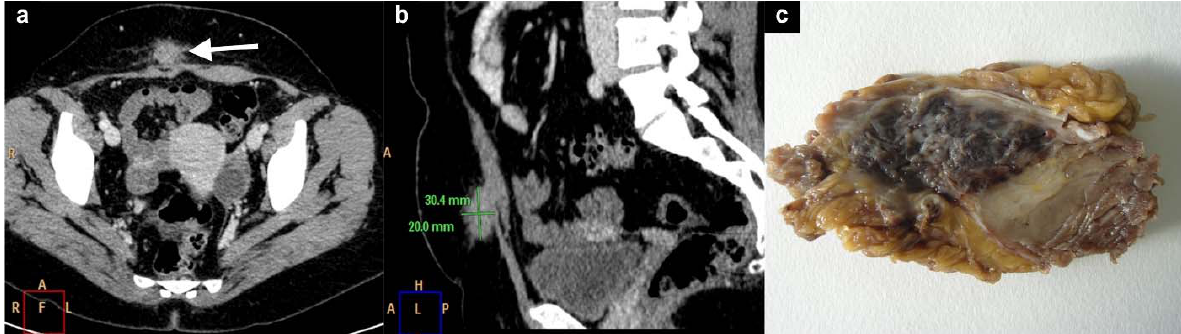
Figure 2. Axial ( a ) and Sagittal ( b ) CT images of a histologically proved ( c ) of subcutaneous endometriosis. A 30 × 20 mm 2 endometriotic nodule (white arrow in a) was detected superficially and in contiguity with the right rectal muscle.